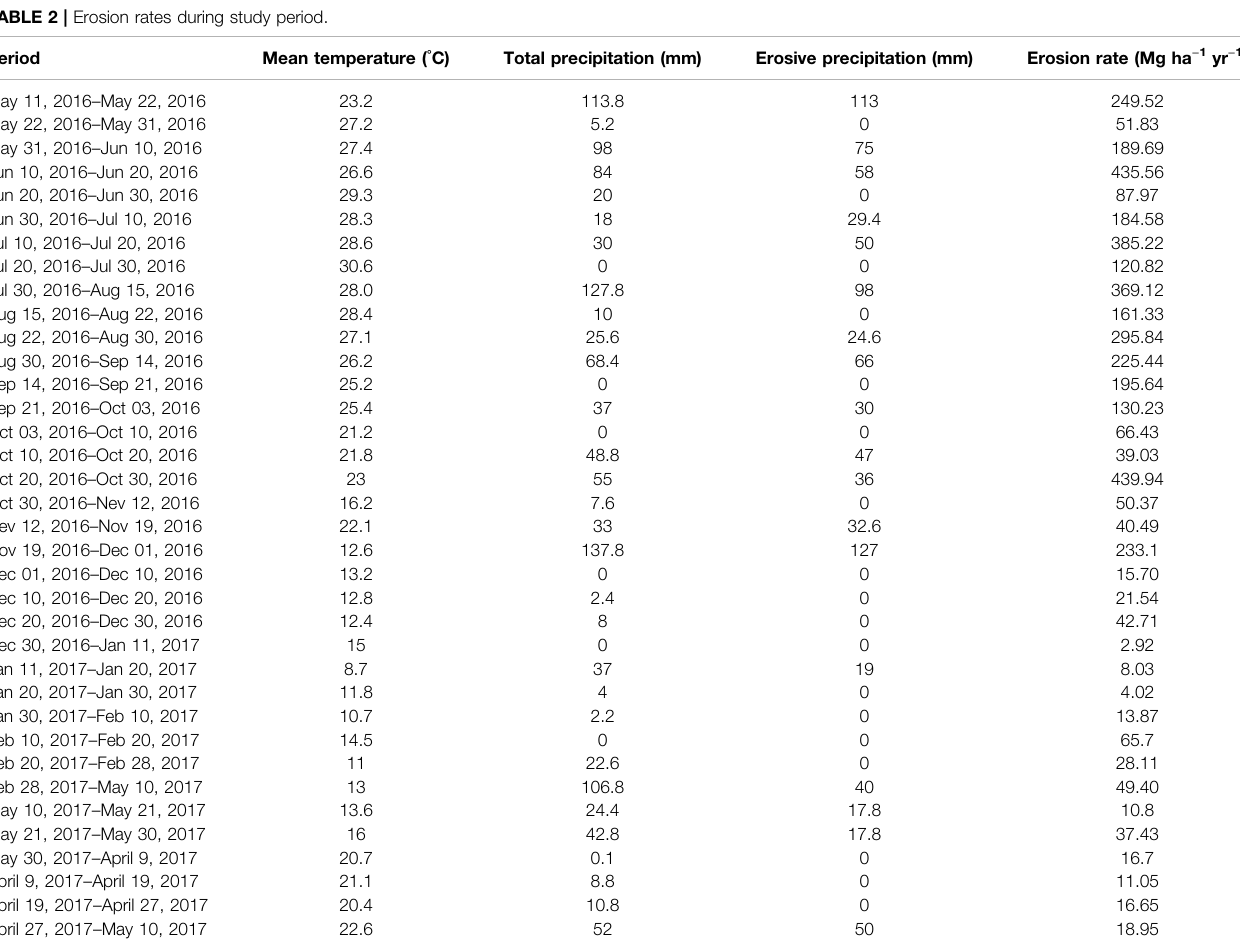
TABLE 2 | Erosion rates during study period. Period Mean temperature ( °